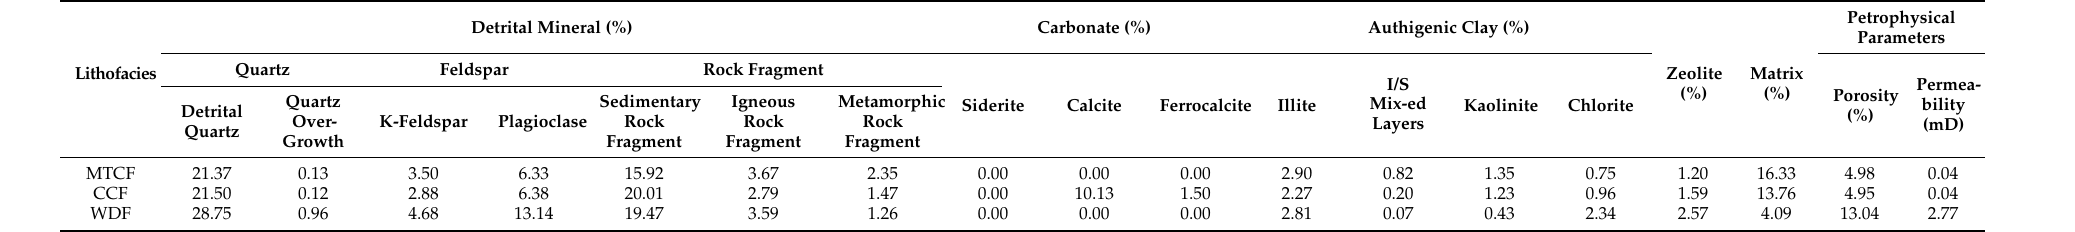
Table 1. Average petrophysical parameters and mineralogical compositions of three lithofacies (Sample number: 23).